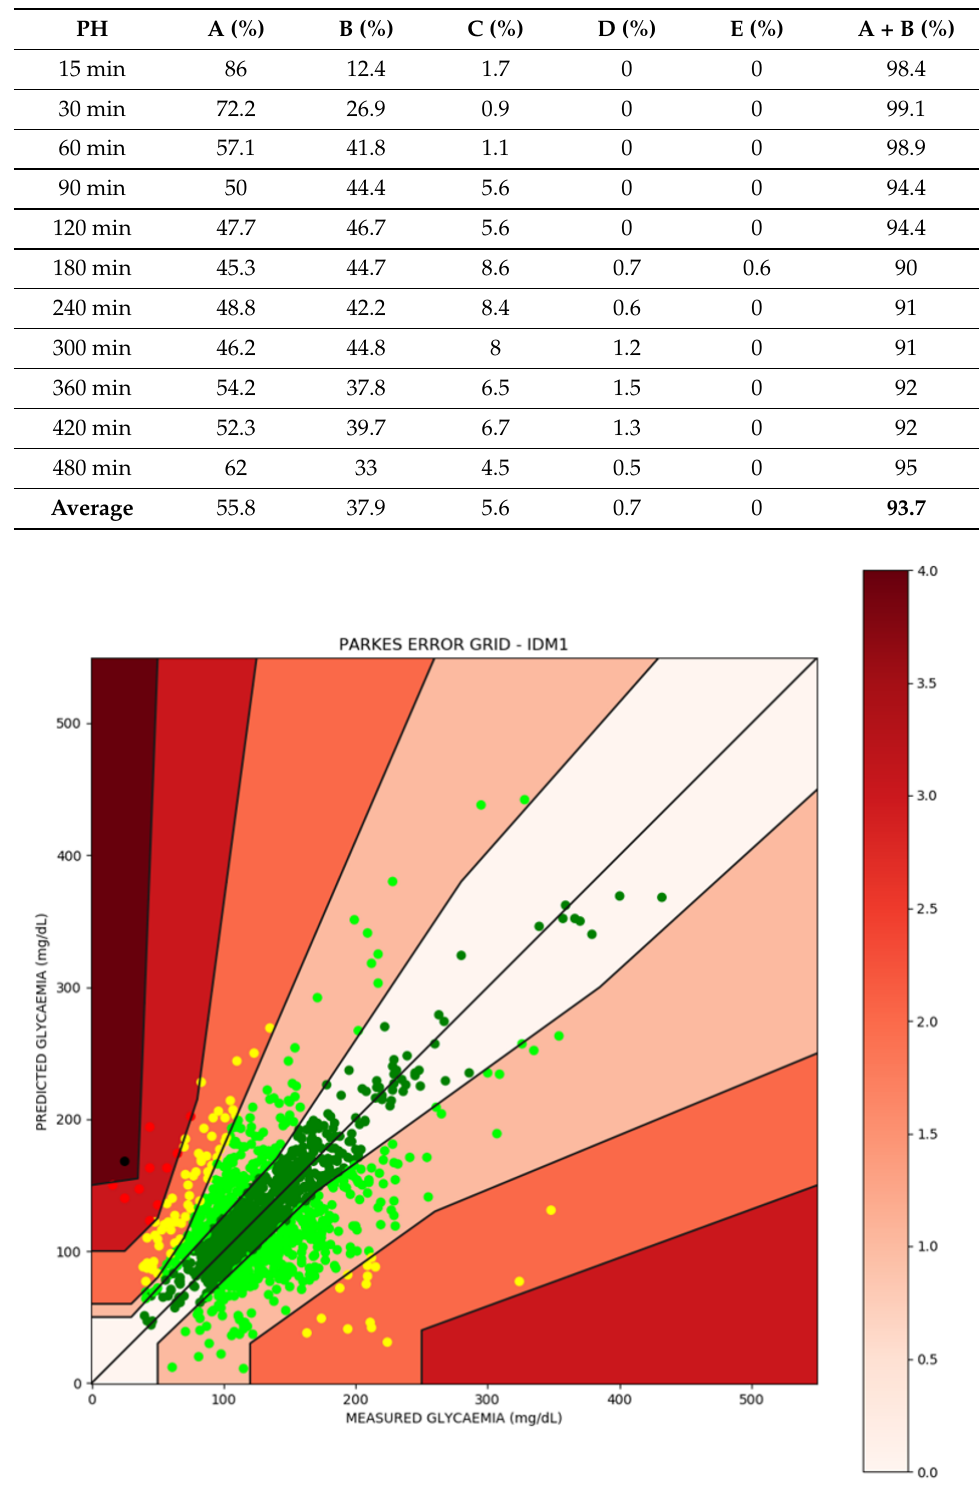
Figure 8. Parkes error grid (night period) for seven T1D individuals. Green dots lay at zones A and B (93.7% on average): 1400